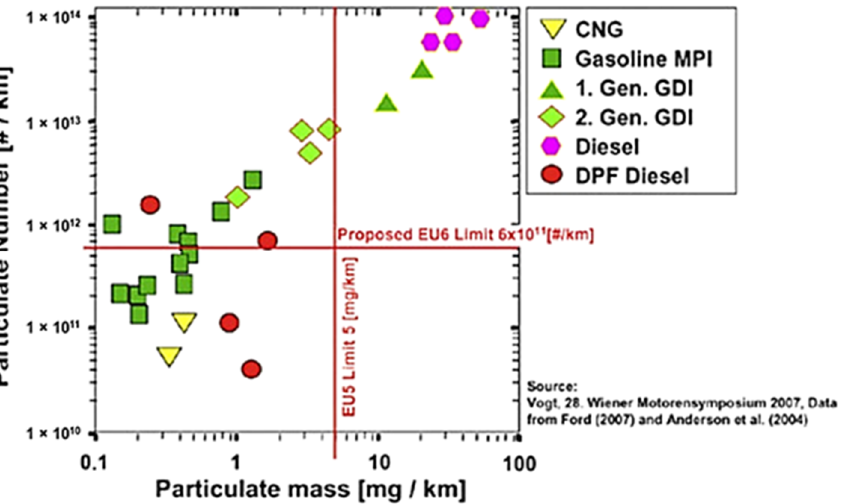
Figure 2. Comparison of particulate number and particulate mass emissions for gasoline and diesel engines. Adapted and reproduced with permission of reference [9].